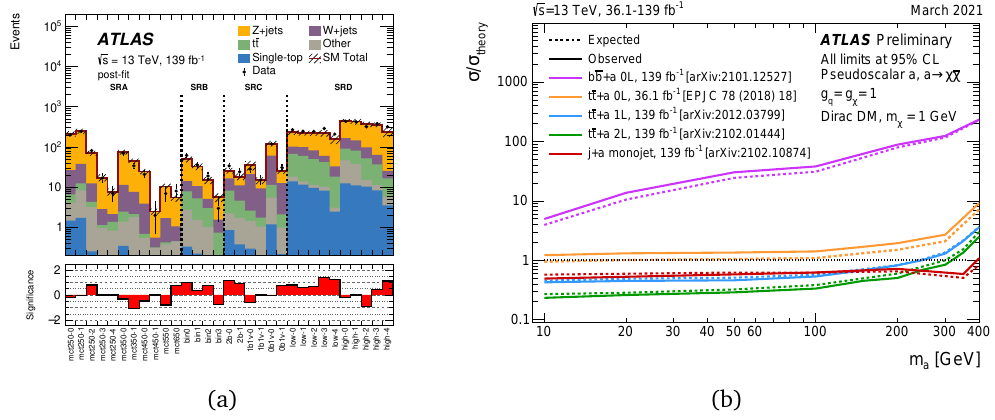
Figure 3: (a) Summary plot of the regions defined in the search for DM in t ¯ t + E miss final states [ 10 ] . (b) Upper limits on the pseudo-scalar mediator mass, for fixed value of DM particles mass and couplings. Figure (b) from [ 8 ]